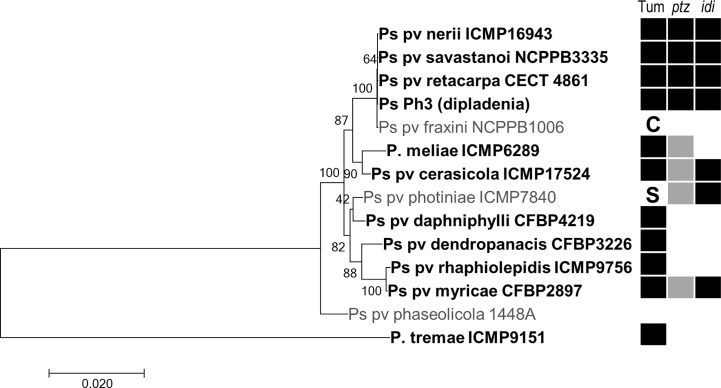
Distribution of cytokinin biosynthesis genes in selected bacteria of the P. syringae complex. ML tree based on the concatenated nt sequence of 10 housekeeping genes of representative strains of each pathovar, inferred using the Tamura–Nei model with a discrete gamma distribution with five categories using MEGA 7. Nodes indicate bootstrap percentages over 200 replicas, and branch lengths are the number of substitutions per site. Bacteria reported to induce tumors are indicated in bold and with a black square (Tum); other symptoms: C, cankers and wart-like excrescences; S, leaf spots and blights. Filled and blank squares indicated presence or absence, respectively, of the gene in each pathovar, as assessed by blast and/or PCR. The two colors for gene ptz indicate the two distinct homologs found.